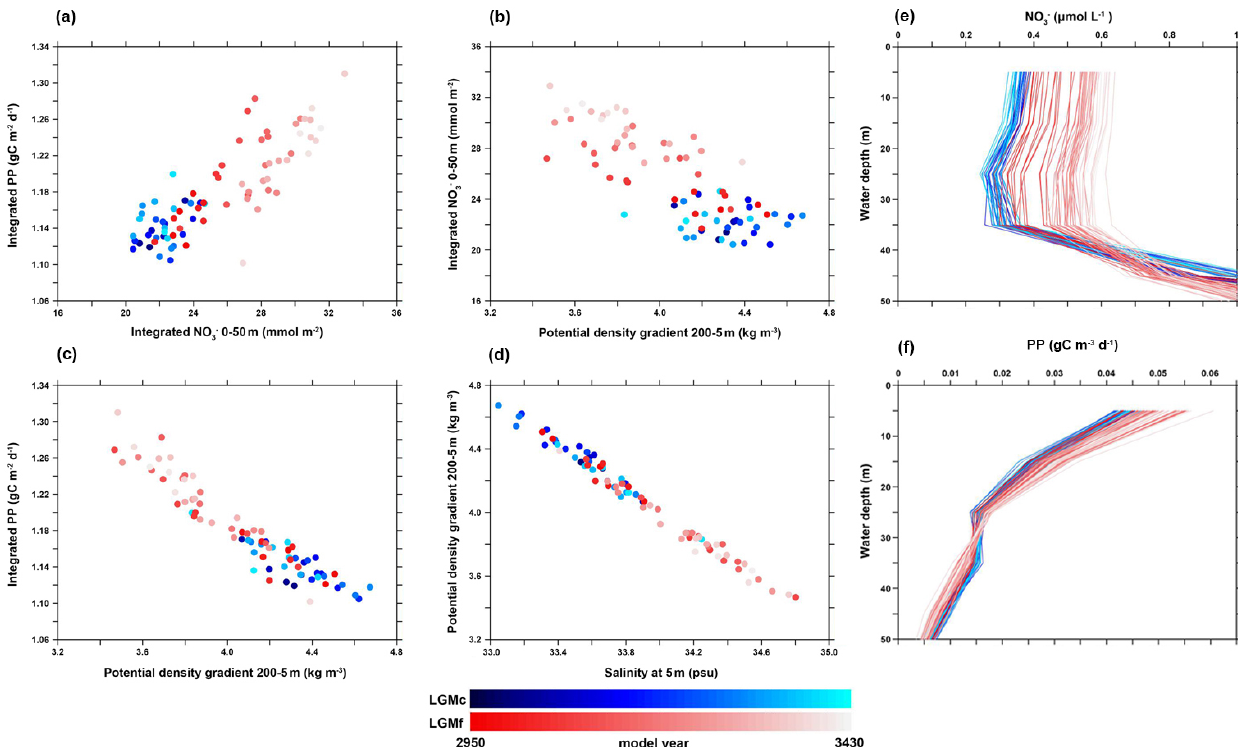
Figure 8. IPSL-CM5A-LR outputs. (a–d) Cross plots between different oceanic parameters in LGMc and LGMf. (e, f) Vertical profiles of nitrate content and PP in LGMc and LGMf. All the results are from winter (December–January–February) and every curve represents an average of 10 model years. Data have been extracted from the grids located in the northeastern part of the BoB close to the MD77-176 core site (rectangle 3 in Fig. 3e). They highlight the control that salinity stratification exerts on upper layer nutrient content and integrated PP: higher PP is found when higher SSS drives weaker